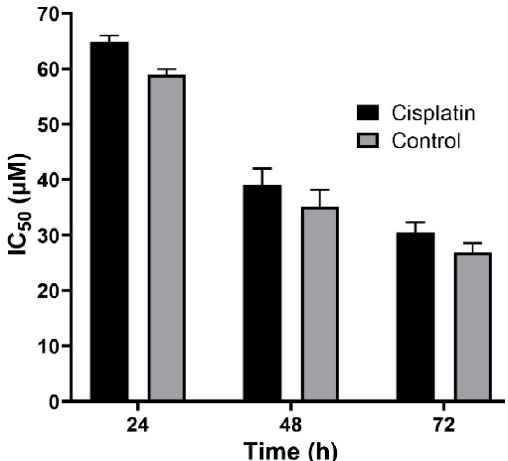
Figure 8. Cytotoxicity effects (IC 50 ) of the control (the combination of the free drug with blank PBCA nanoparticles) and cisplatin against BHK-21 cells (39.9 ± 1.0, 21.4 ± 1.5, and 19.0 ± 1.1 µM after 24-, 48-, and 72-h incubation, respectively). The data were expressed as mean ± SD (n = 3).